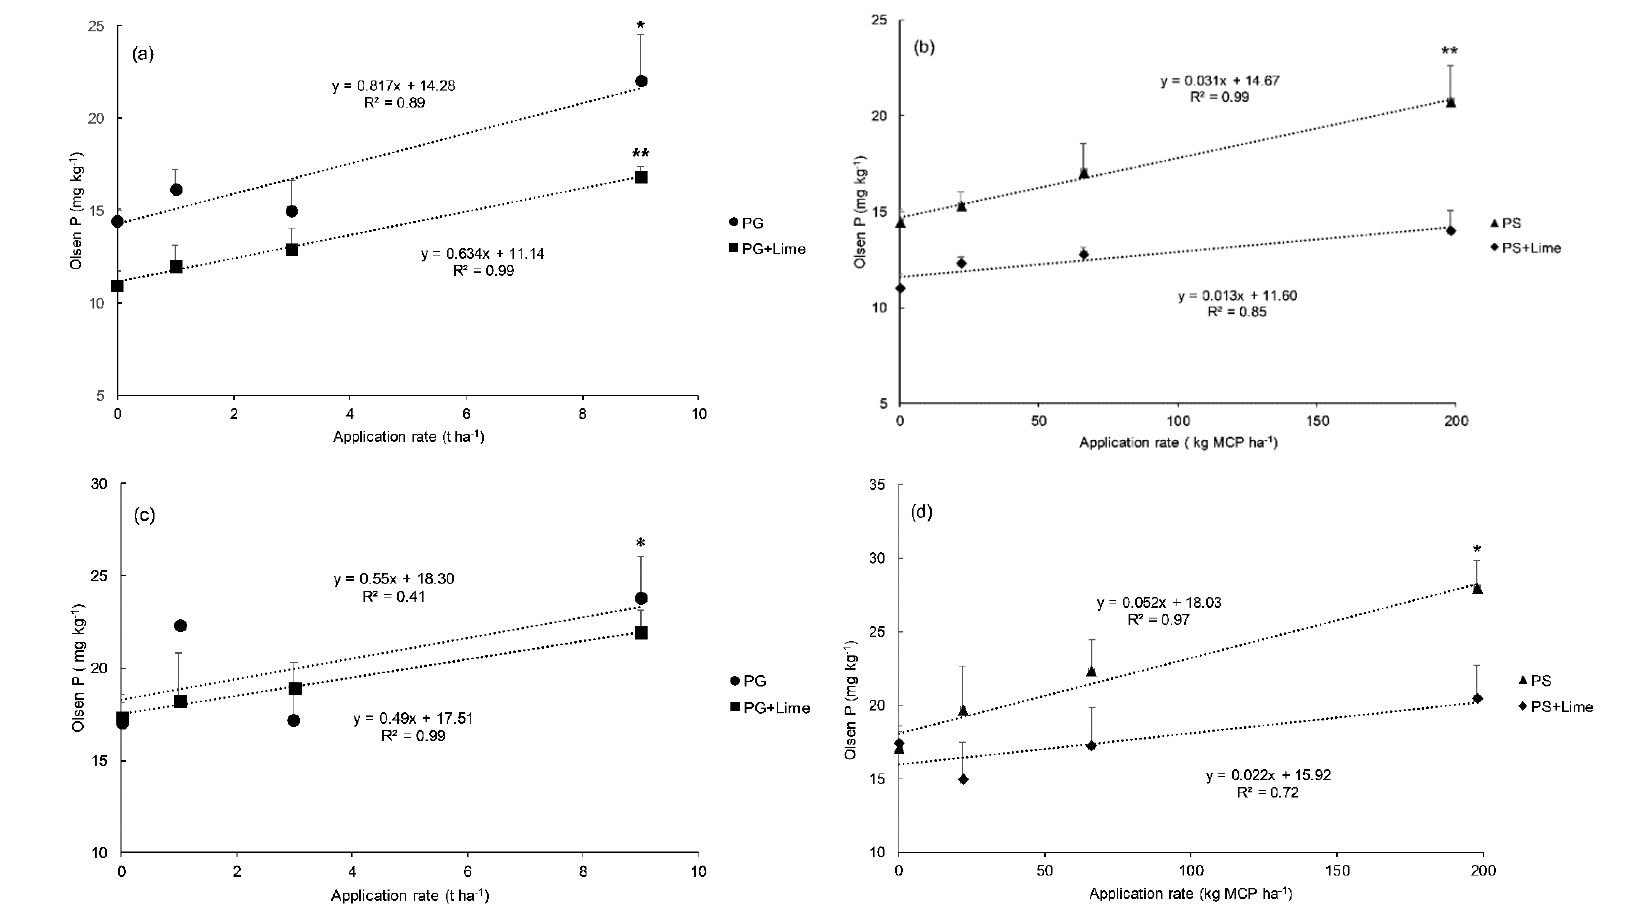
Figure 3. The relationship between mean Olsen P (mg kg − 1 , n = 4) and application rate of phosphogypsum (PG, t ha − 1 )) and soluble fertilizer (PS, kg of MCP ha − 1 ) combined or not with lime under Molesworth ( a , b ) and Glenmore ( c , d ) soils, separately. Error bars indicate upper standard errors (SEM, n = 4). MCP: mono-calcium phosphate (CaHPO 4 ). Asterisks indicate the application rates which are significantly different from the control (0 tons or 0 kg ha − 1 ), according to the Dunnett test at 5%. * and ** indicate a one-way ANOVA significance level of 5 and 1%.